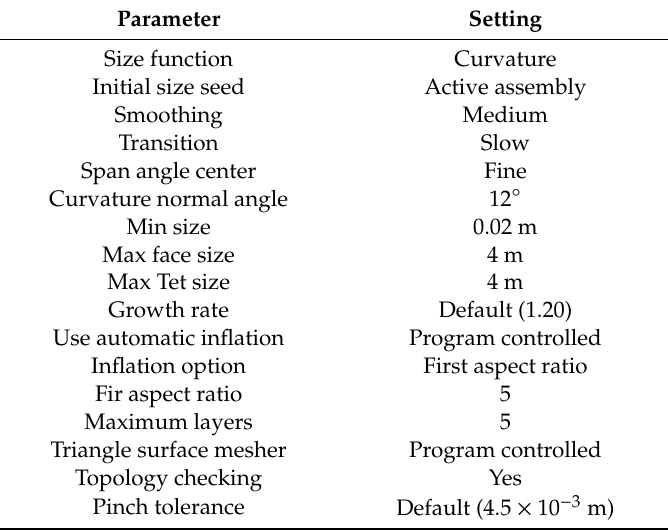
Table 1. Settings for meshing the fluid domain of interest.